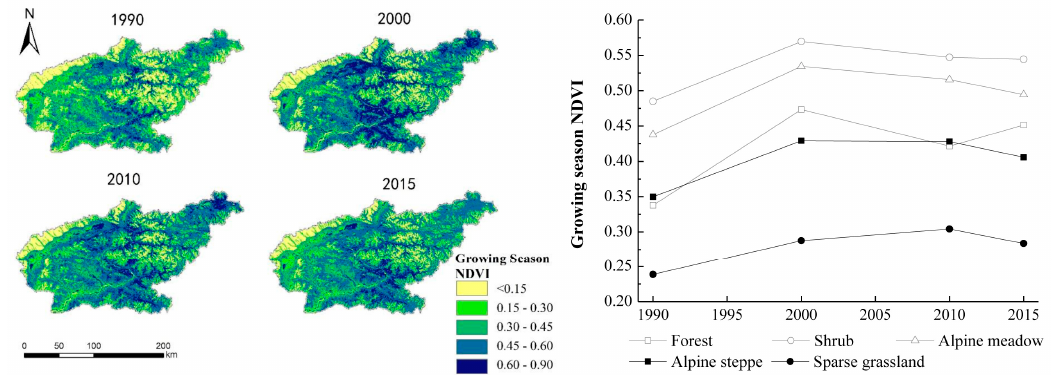
Figure 6. Growing season normalized difference vegetation index (NDVI) distribution and changes di ff erent vegetation types from 1990 to of different vegetation types from 1990 to 2015.